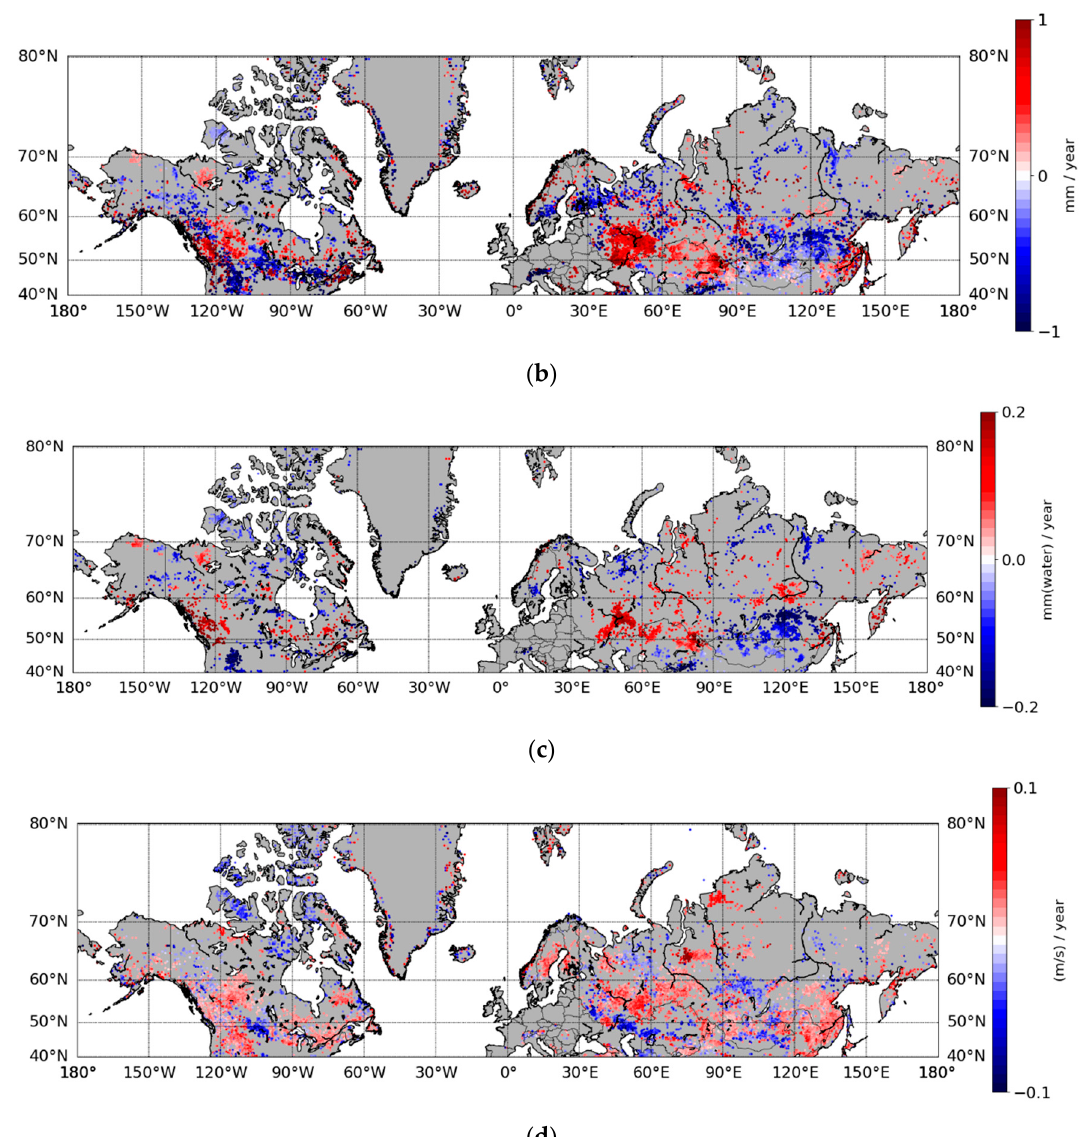
Figure 7. ERA-Interim trends for 1982–2015 for ( a ) mean air temperature ( b ) accumulated precipitation ( c ) snowfall (units are given as amount of snow converted into liquid water) ( d ) wind speed for 14 days prior to melt onset. The maps show trends for which the coefficient of determination was larger than 0.5.